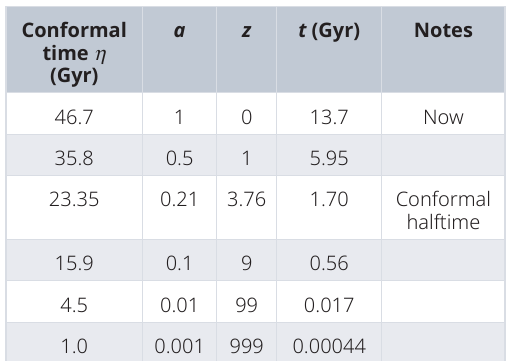
Table 1. Values of scale factor a , redshift z and age t of the universe, listed for conformal times η represented by dotted horizontal lines in Figure